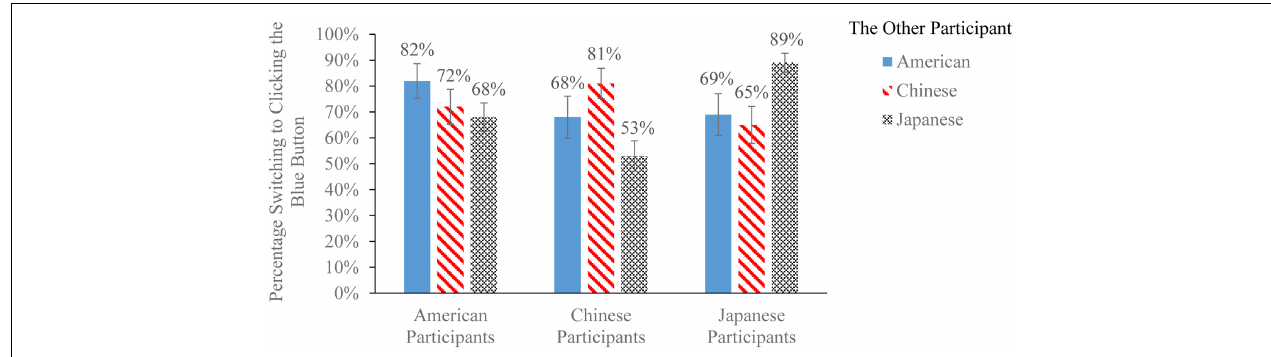
FIGURE 3 | Percentages switching from offensive to defensive preemptive strikes among American, Chinese, and Japanese participants ( ± 1 SE) in the red-blue-button PSG, facing a different participant from each of the three countries. Participants decided to stick to their previous red-button decisions (offensive preemptive strikes) or switch to clicking a blue button instead (defensive preemptive strikes). Decisions were incentivized. Results were based on participants who correctly identified the pay-off rules for this task (United States: N = 33; China: N = 45; Japan: N =